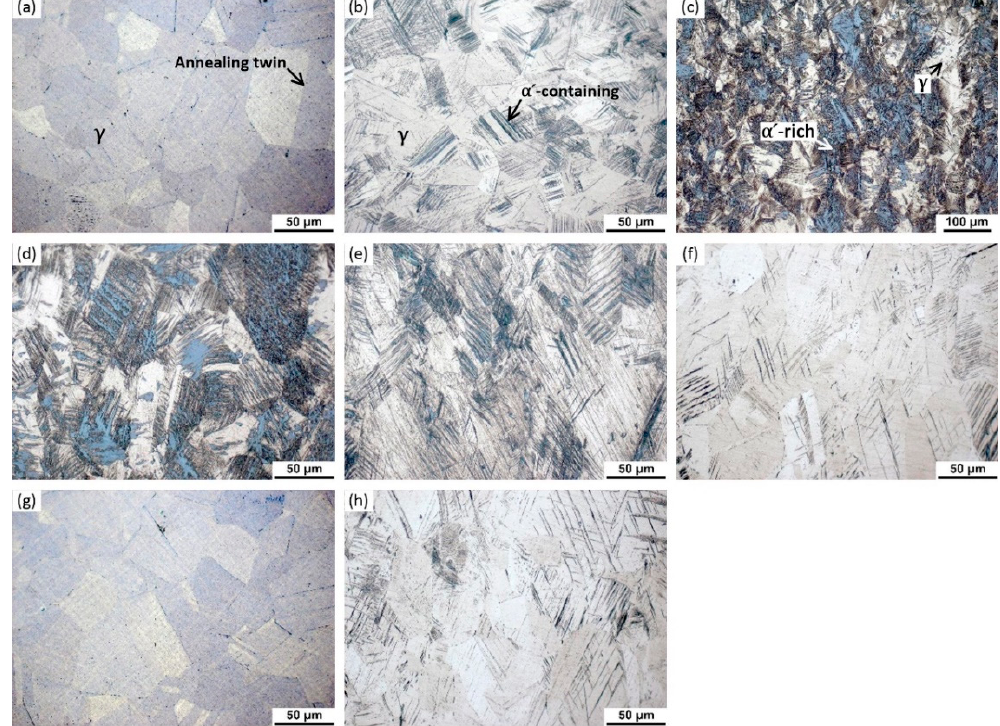
Figure 3. OM images: ( a ) 304L un ‐ prestrained; ( b ) 304L prestrained to 10% at 20 °C; ( c , d ) 304L prestrained to 30% at 20 °C; ( e ) 304L prestrained to 30% at 50 °C; ( f ) 304L prestrained to 30% at 80 °C; ( g ) 316L un ‐ prestrained; ( h ) 316L prestrained to 40% at 20 °C. The etched dark regions within the bunches of shear bands contain α′ martensite; the darker the region, the more the α′ martensite.